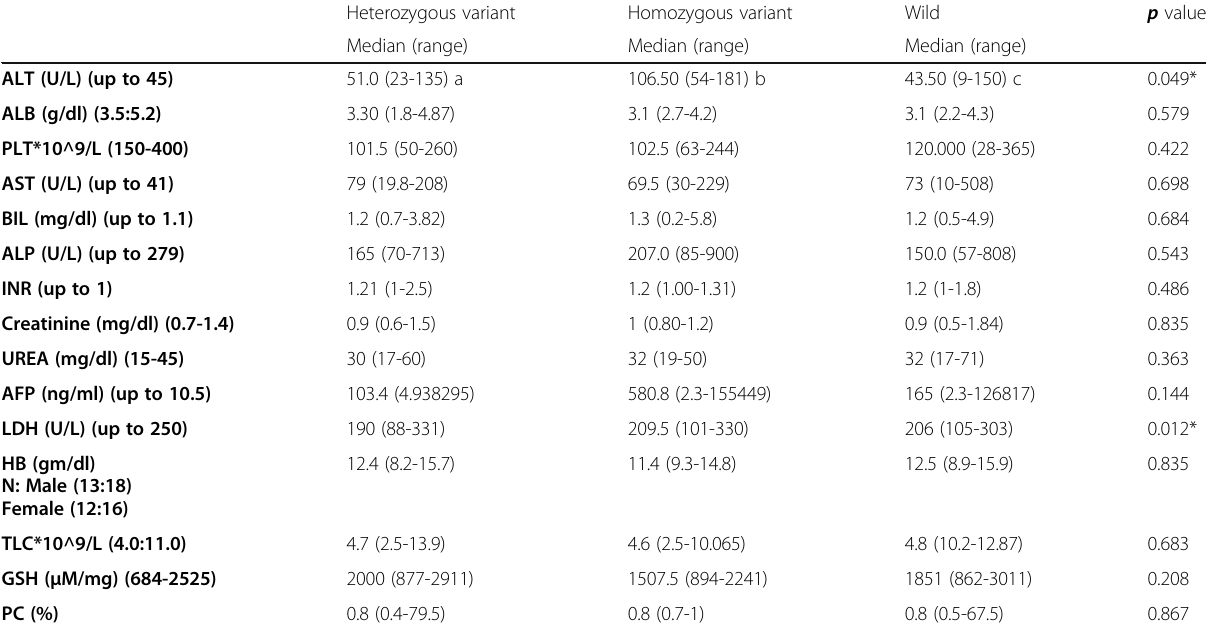
Table 6 Comparison of some laboratory markers according to GSTP1 genotype